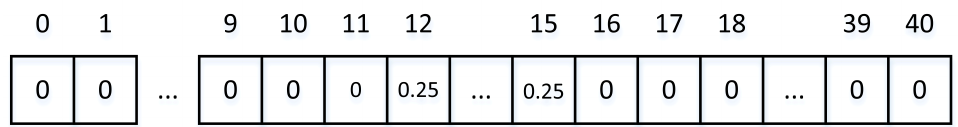
Figure 3. An example of ‘K32.AK95.T874.A6’ encoding.